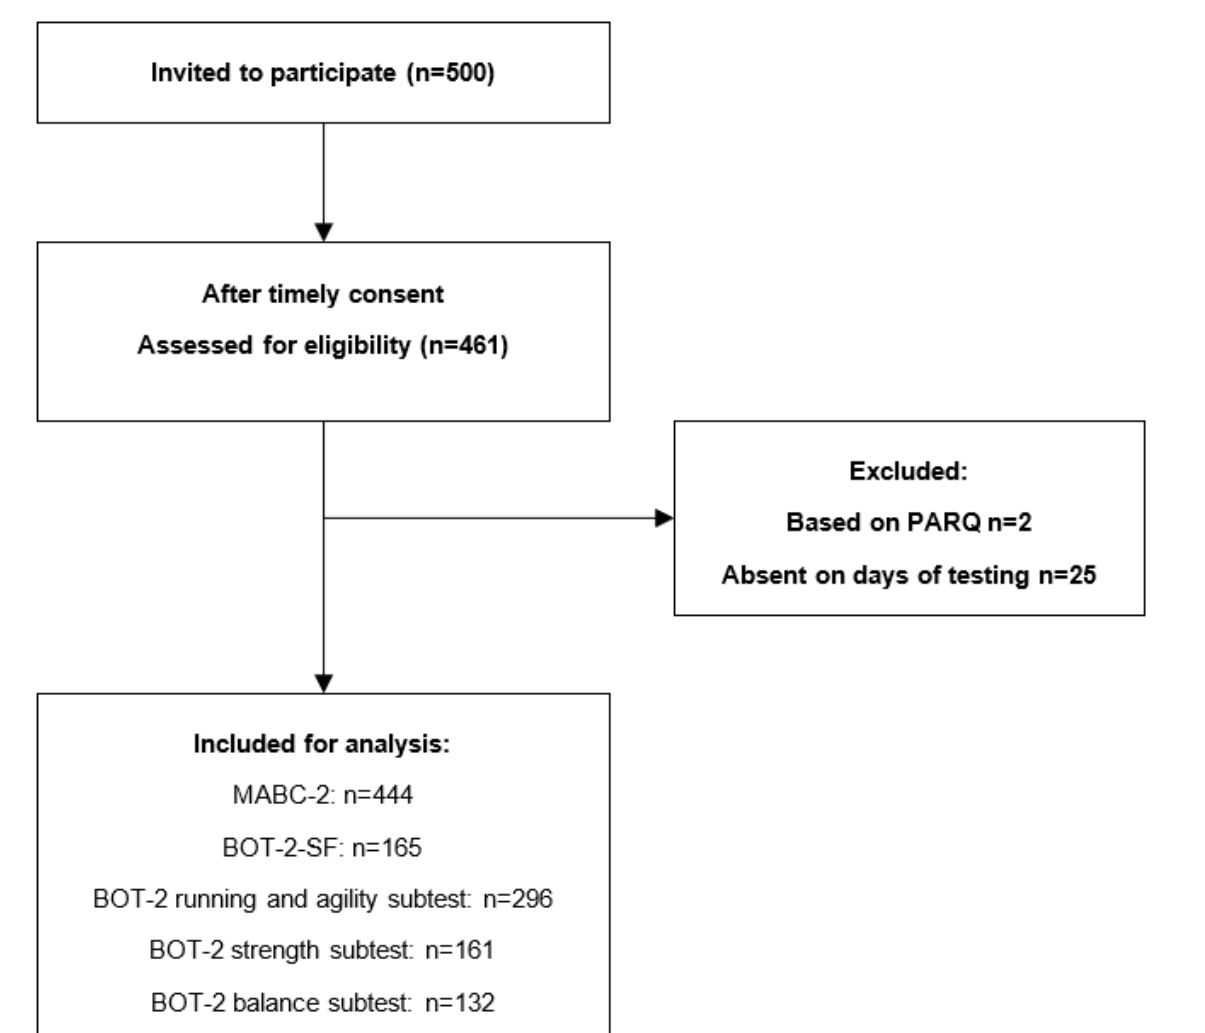
Figure 1. Flowchart of the selection procedure and number of children in the final analysis. Children whose caregivers answered in the affirmative on any of the questions of the children’s Physical Activity Readiness Questionnaire (PAR-Q) were excluded from the study.